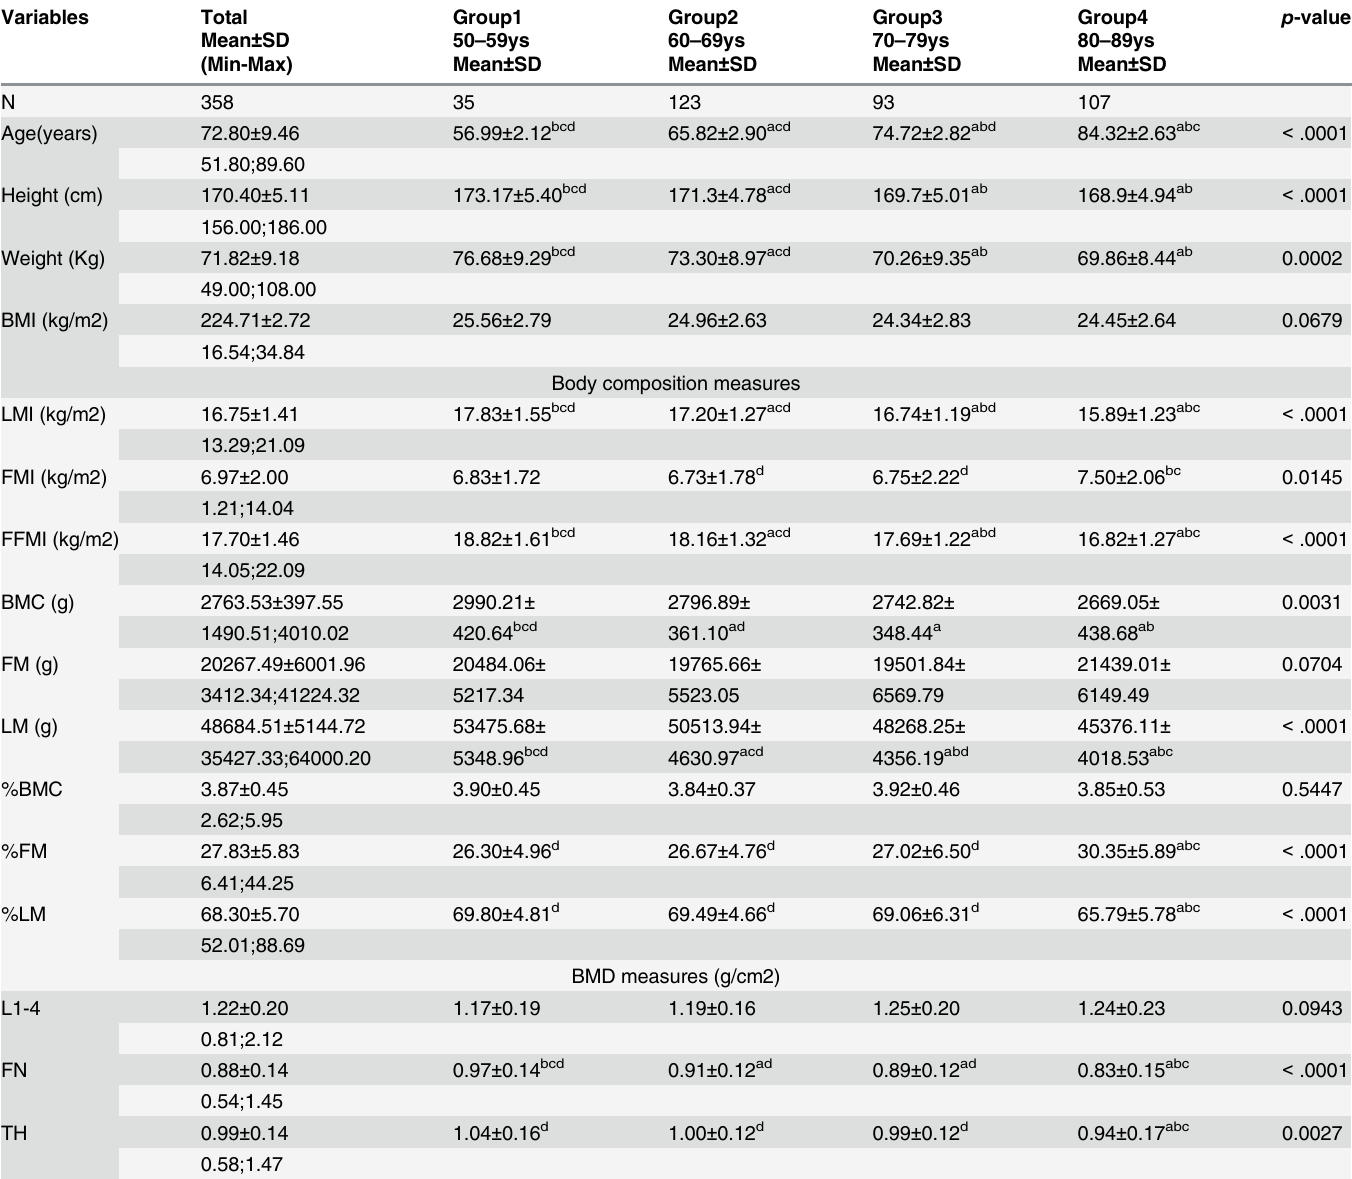
Table 1. Subject characteristics by